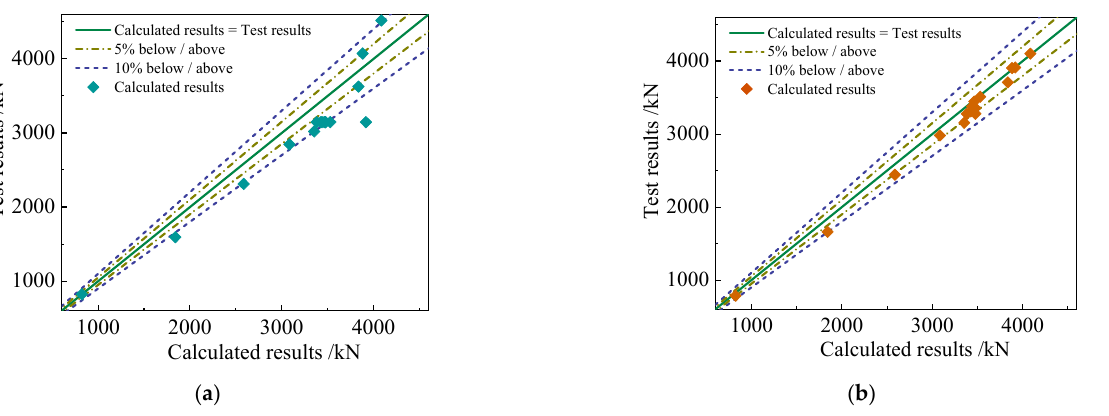
Figure 20. Comparing the calculation results of ( a ) code JGJ138-2016 and ( b ) the revised formula with the test data.